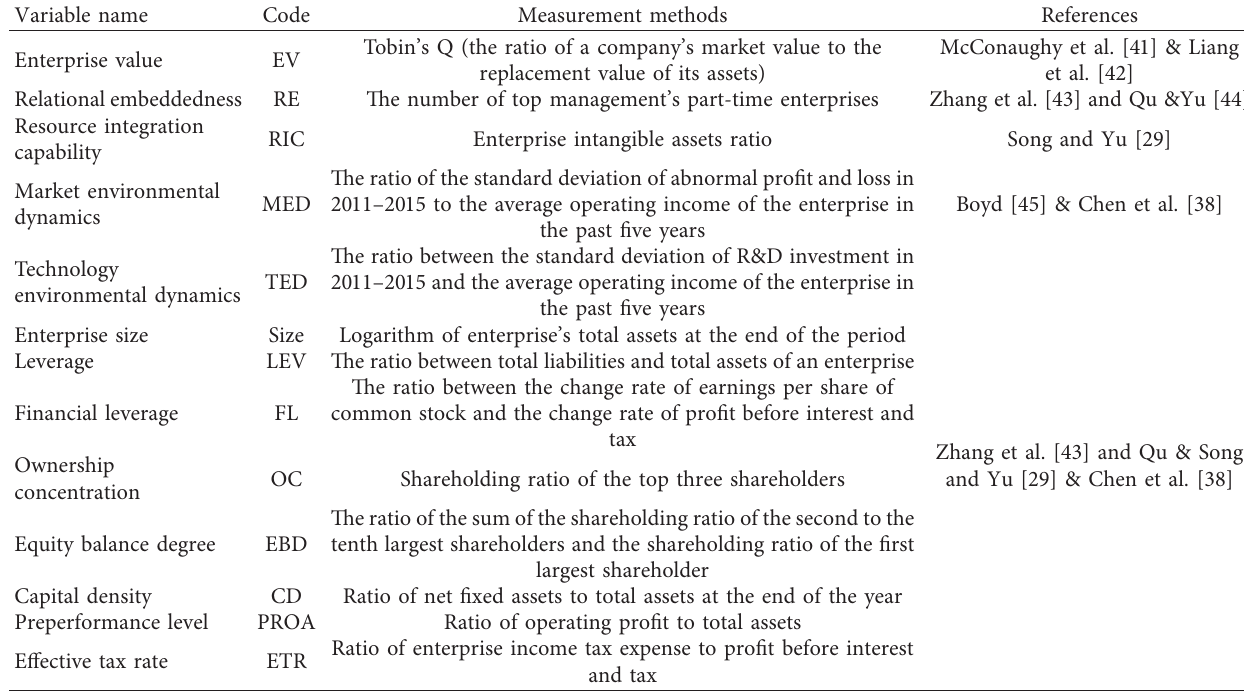
Table 1: Measurement methods of variables.